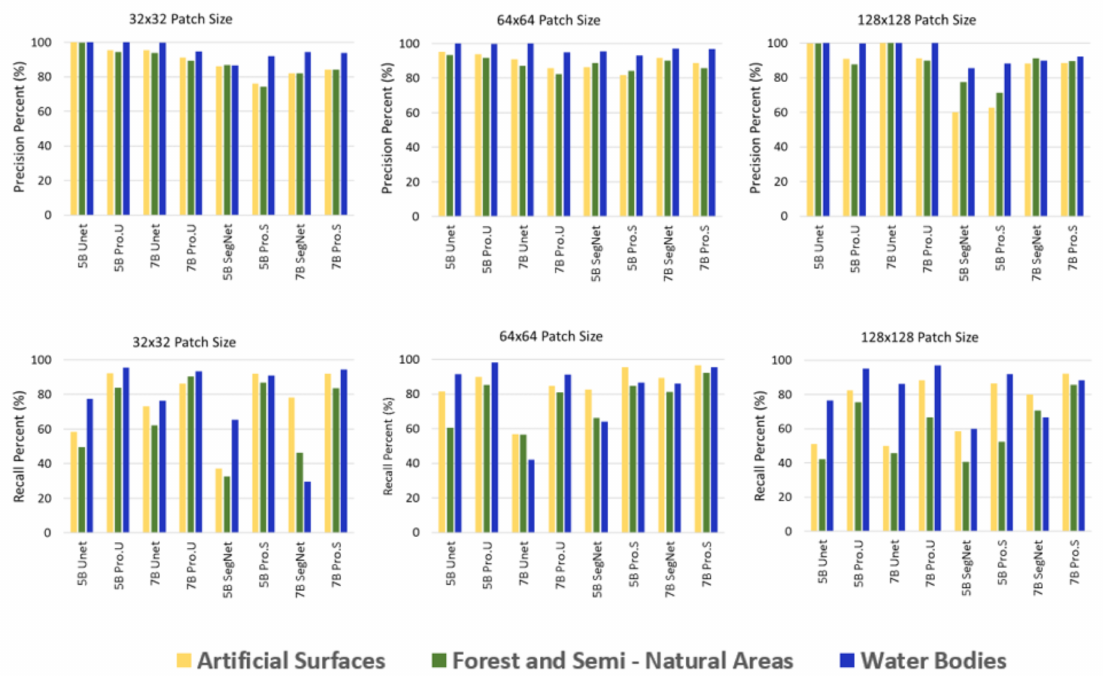
Figure 17. Precision and recall values of different patch sizes for Kocaeli test area. Pro.U is proposed approach as CNN (U-Net)–MRS and Pro.S is proposed approach as CNN